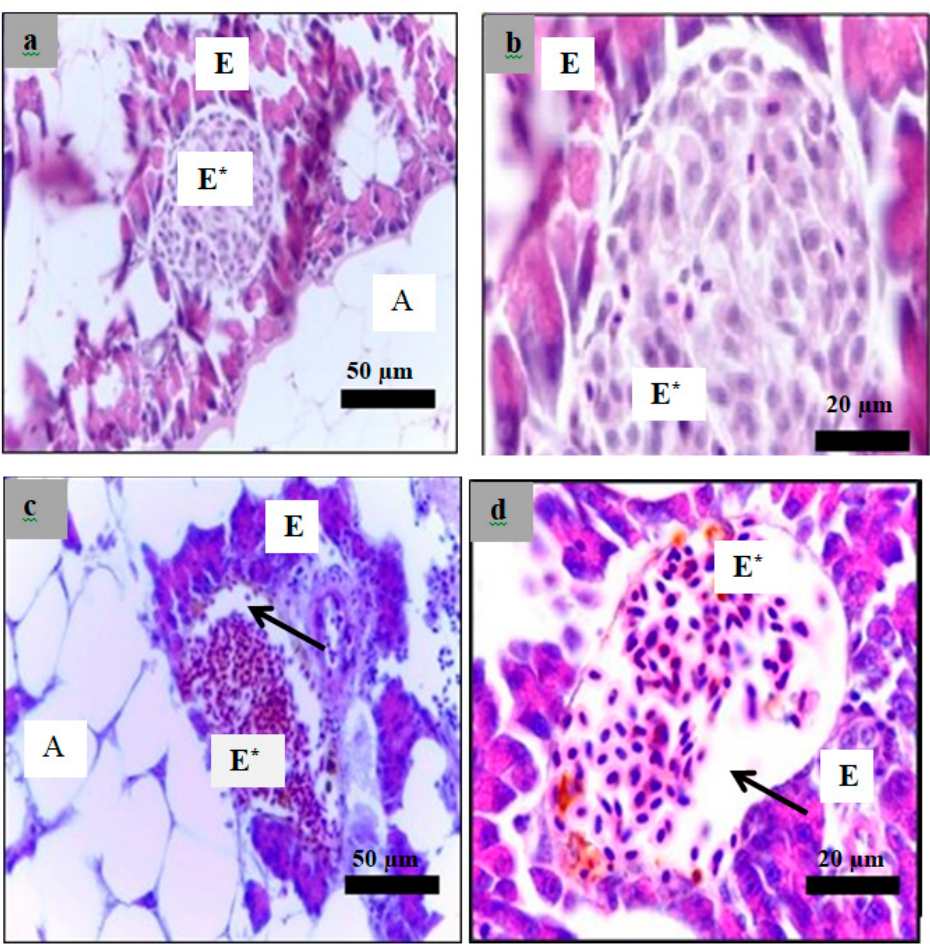
Figure 11. Paraffin section of the islet of the zebrafish pancreas analyzed using hematoxylin and eosin. Healthy group sections ( a : 40× magnification; b : 100× magnification) showed normal histology of pancreas with high cellularity of Langerhans. Alloxan injected group sections ( c : 40× magnification; d : 100× magnification) showed a high reduction of endocrine islets cellularity as indicated by the arrows in the alloxan group. E*: endocrine part, E: exocrine part. A: adipose tissue.